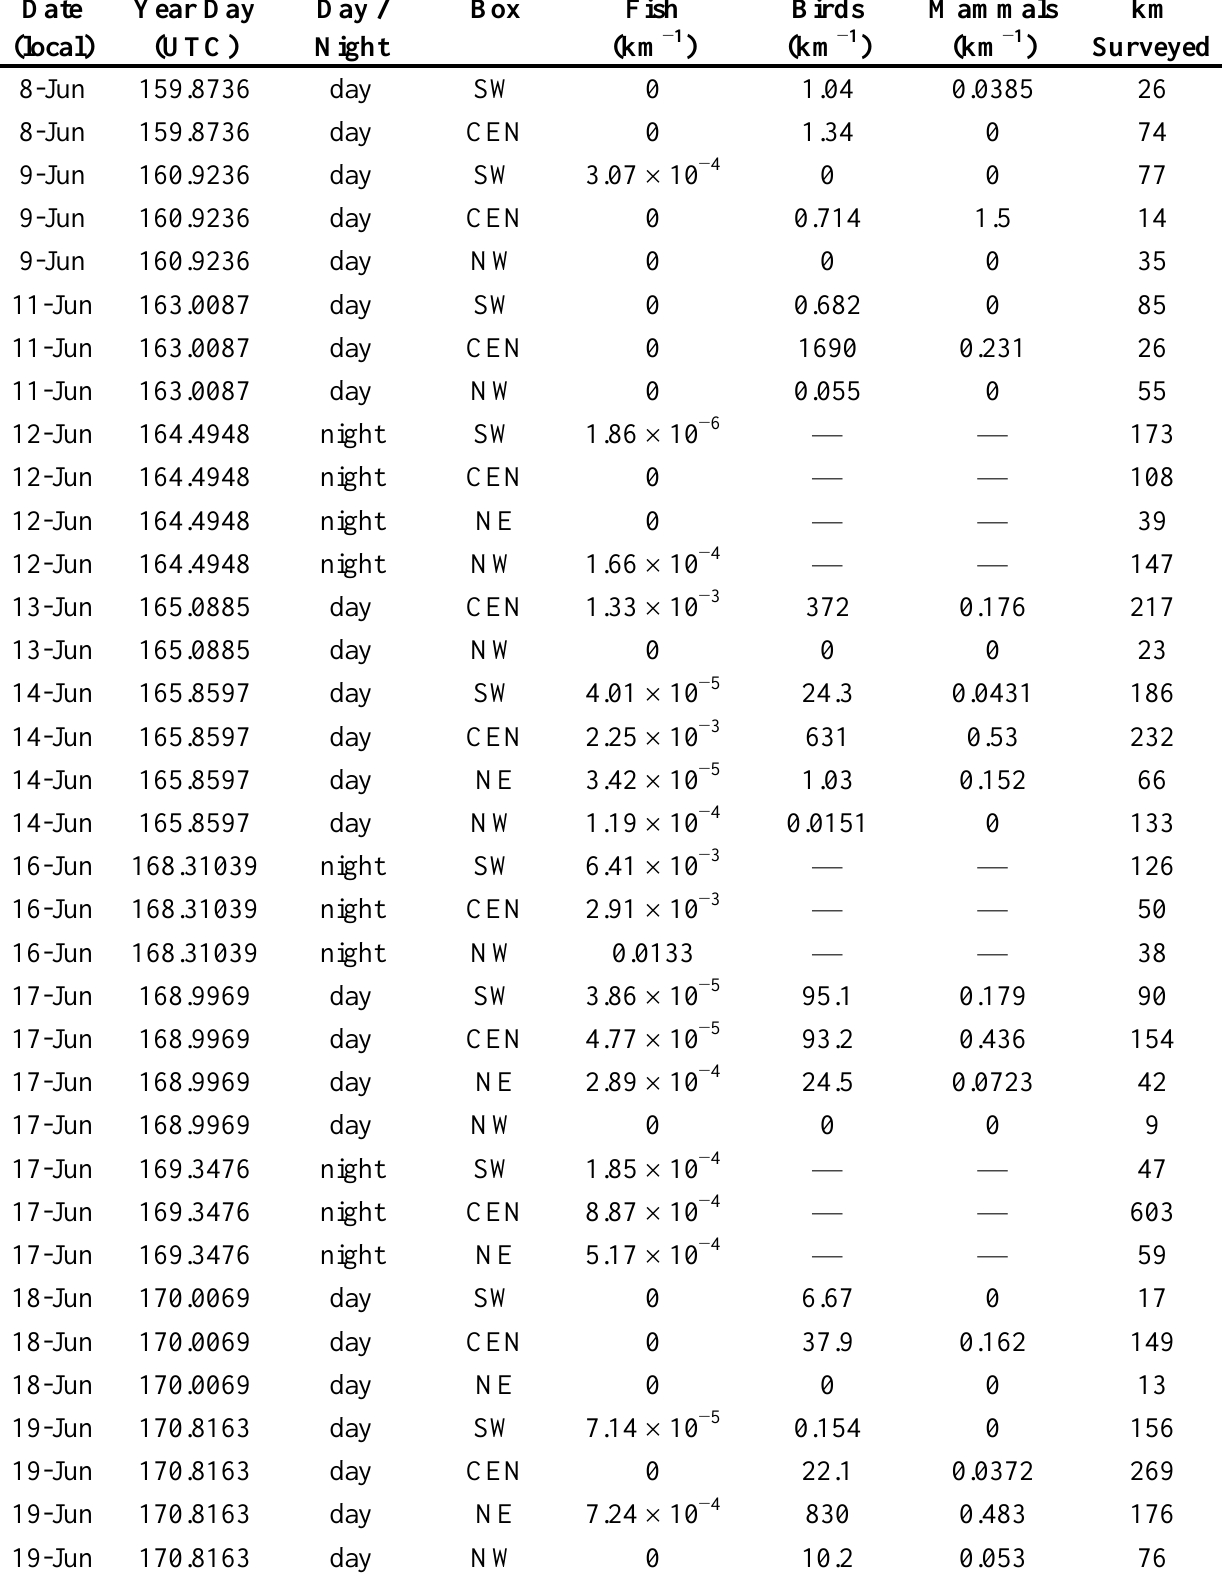
Table S1. Density of fish schools (km −1 ) based on lidar and visual estimates of birds and marine mammal densities (km −1 ) for each of the four boxes, and for each flight. Flight timing and survey length within the box are also presented. Note that visual observations (birds and mammals) were not made during night